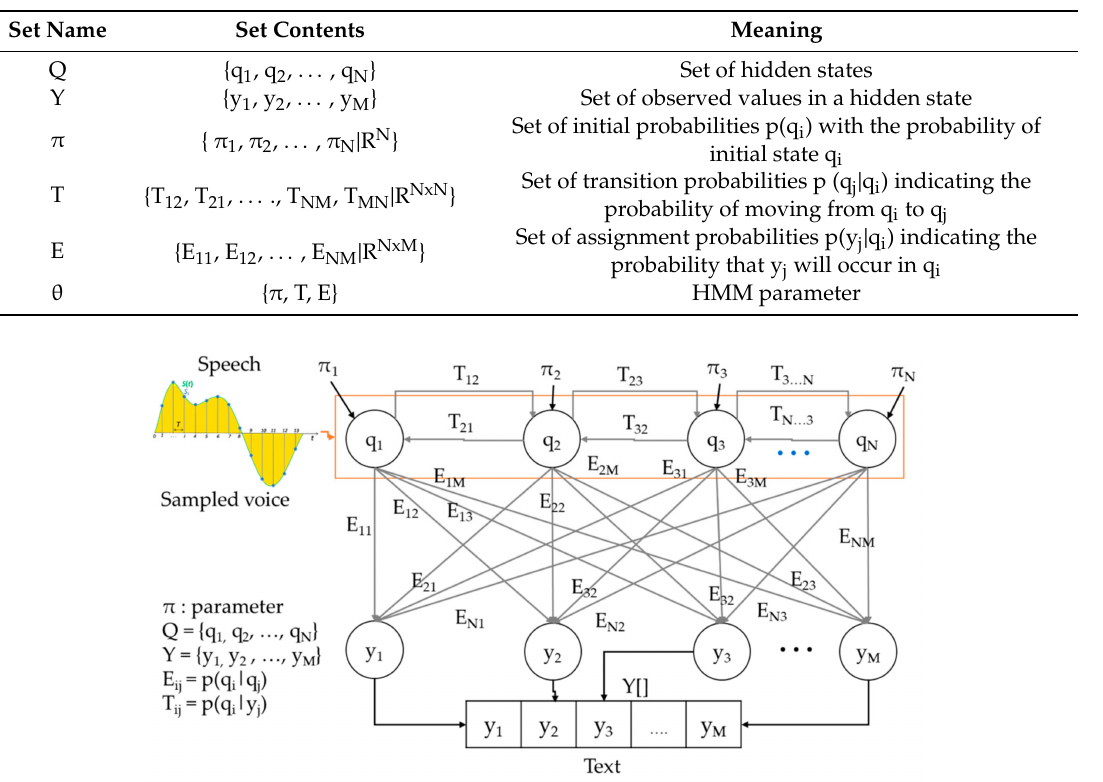
Table 1. Components of HMM.